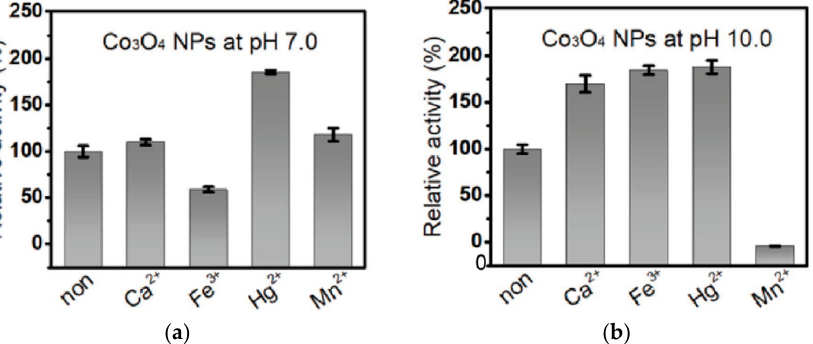
Figure 13. Influence of metal ions on the catalase-like activity of Co 3 O 4 nanoparticles at ( a ) pH 7.0 and ( b ) pH 10.0. (Re- printed with permission from [112] . Copyright © 2018, John Wiley and Sons).